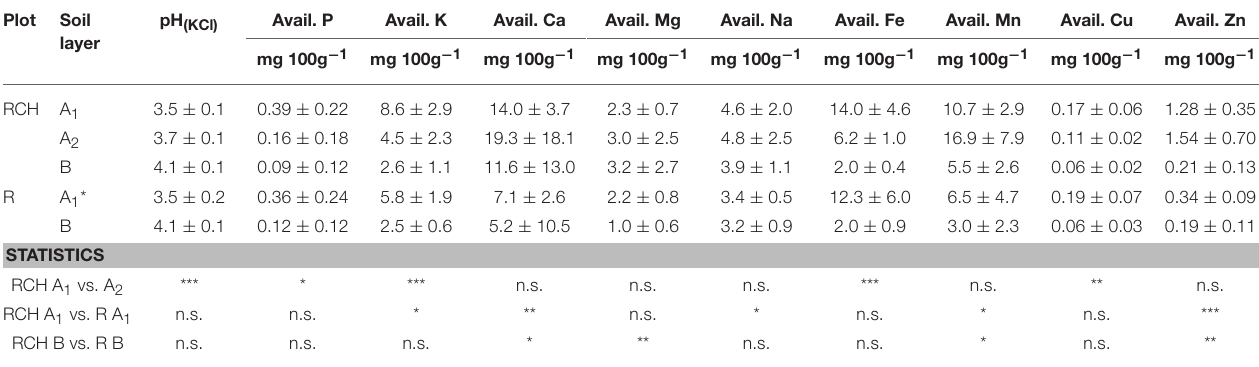
Data for each soil layer are reported as mean value with related standard deviation (n = 9). A t-test (or the Mann-Whitney Rank Sum Test if data did not pass the normality test and the equal variance test) was performed comparing separately the same soil layers between RCH and reference soils, and the top and the bottom part, A 1 and A 2 layer, of the charcoal-enriched layer. Level of significance is shown as: n.s.: not significant; * p < 0.05; ** p < 0.01; *** p < 0.001. * Mean and standard deviation of n = 8. Here one sample showed outliers values indicating a likely contamination.